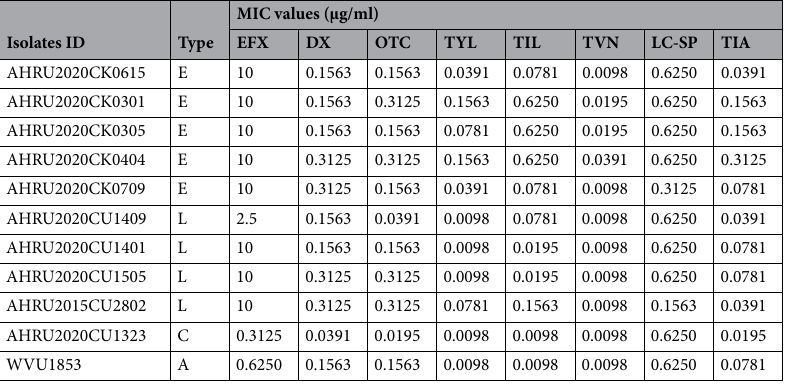
Table 3. Details of 9 M . synoviae isolates in 2020, 1 M . synoviae isolate in 2015 and WVU 1853 as M. synoviae isolate reference strain and final MIC values of M. synoviae isolates. Abbreviations of antibiotics: EFX enrofloxacin, DX doxycycline, OTC oxytetracycline, TYL tylosin, TIL tilmicosin, TVN tylvalosin, LC-SP lincomycin-spectinomycin, TIA tiamulin.